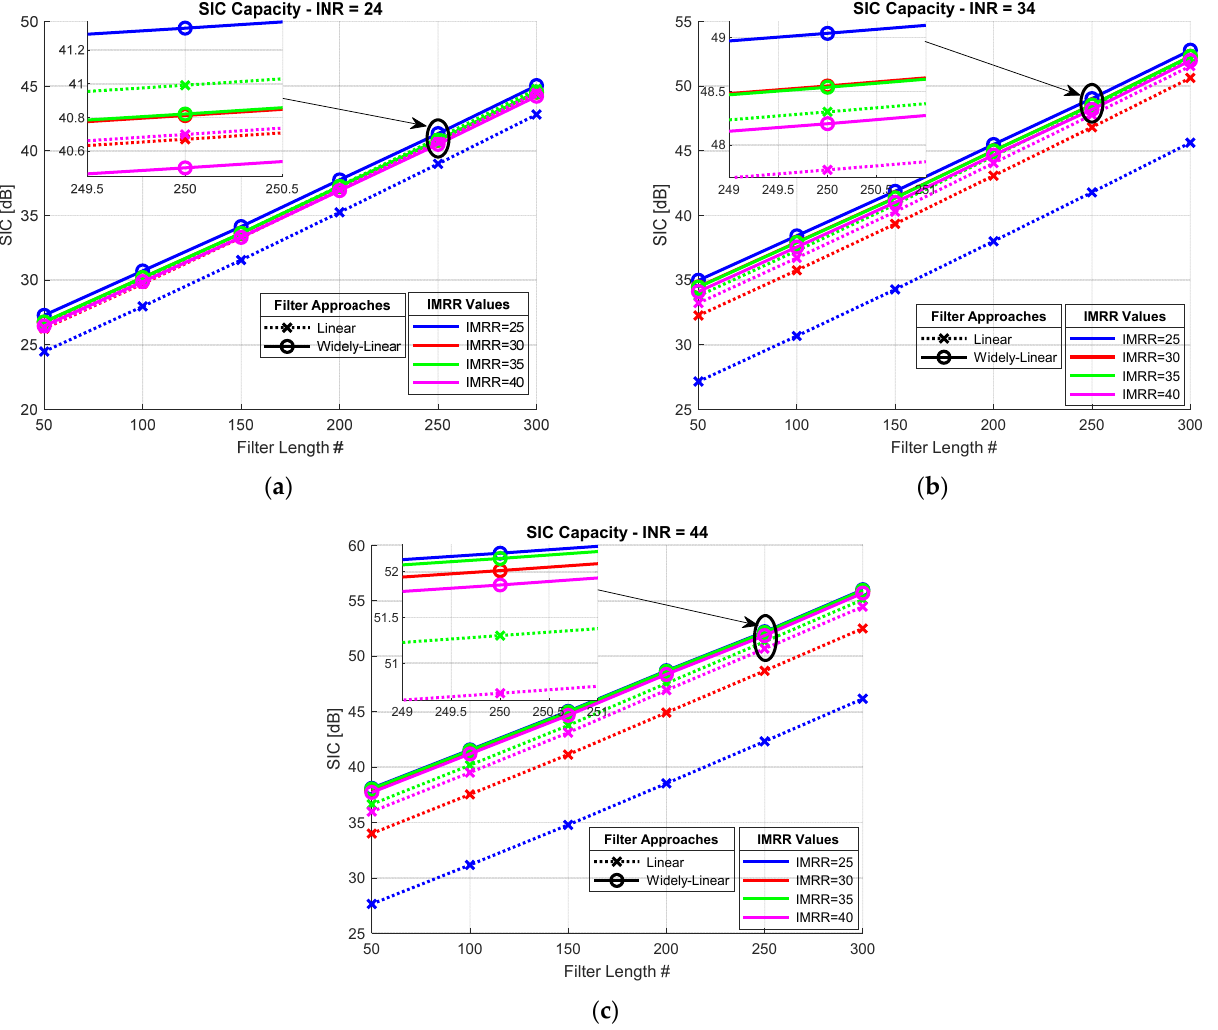
Figure 5. Digital SIC capability achieved for different IMRR values considering: ( a ) INR = 24 dB, ( b ) INR = 34 dB, and ( c ) INR = 44 dB.